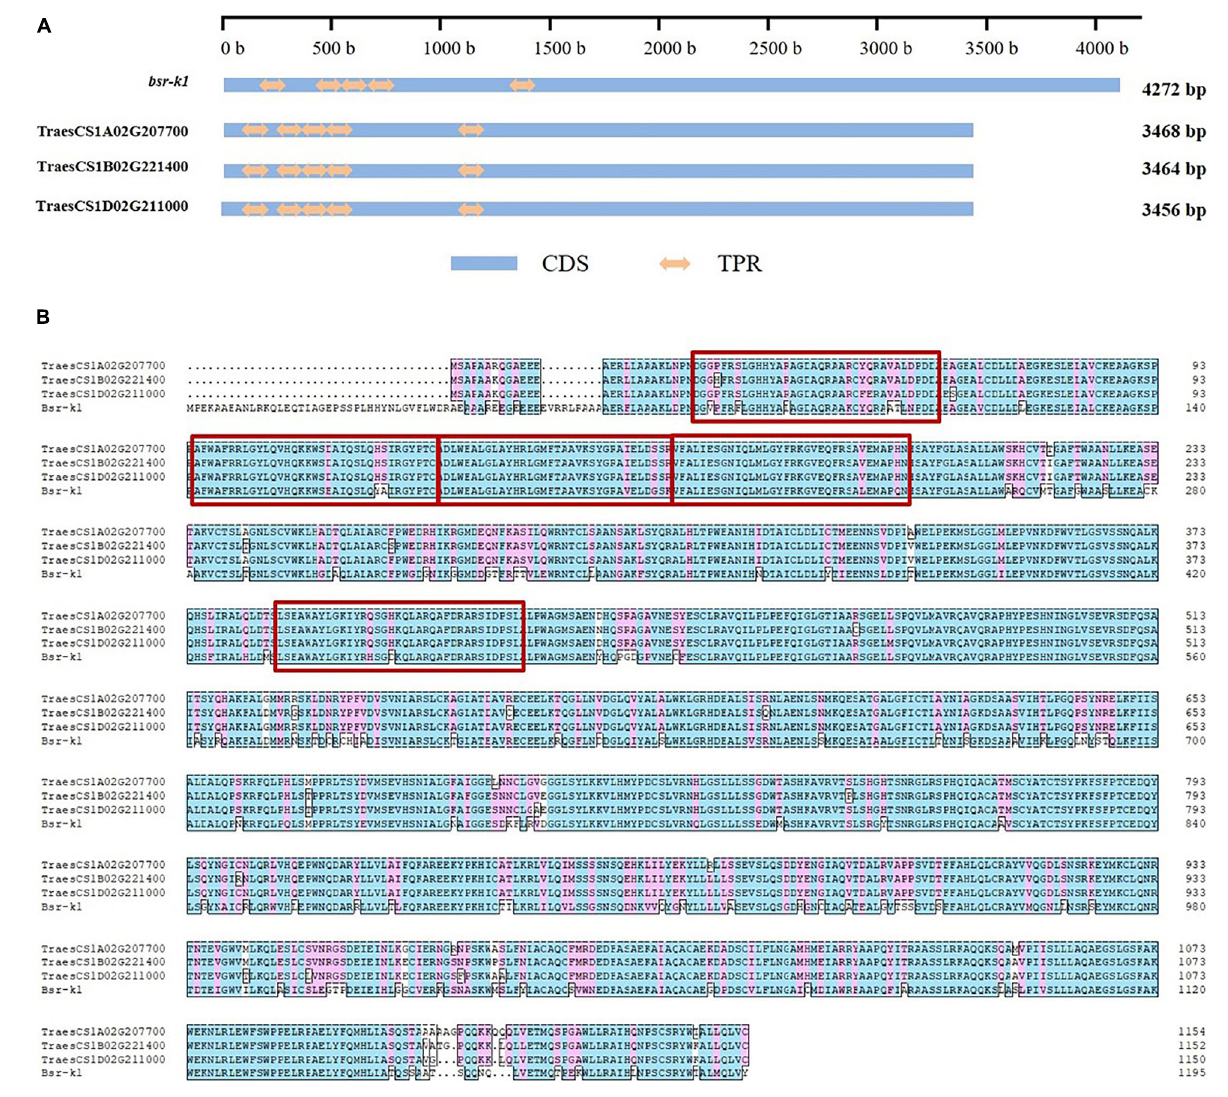
FIGURE 1 | Conserved domains and amino acid sequence of gene Bsr-k1 and its respective wheat orthologs. (A) conserved domains, (B) amino acid sequence. CDS means coding sequence, TPR means tetratricopeptide repeat, the TPRs are highlighted by red